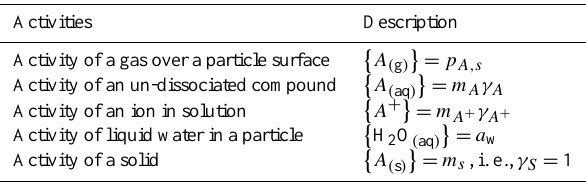
Table 1. Description of activities implemented in SPACCIM. Activities Description Activity of a gas over a particle surface